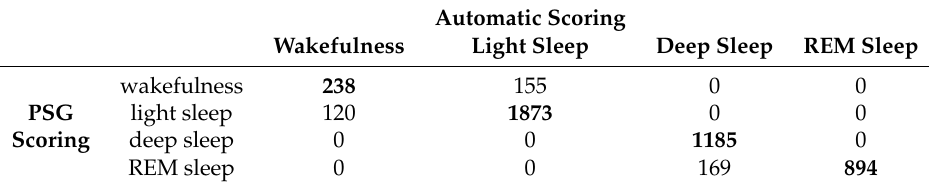
Table 3. Confusion matrix for healthy subjects.